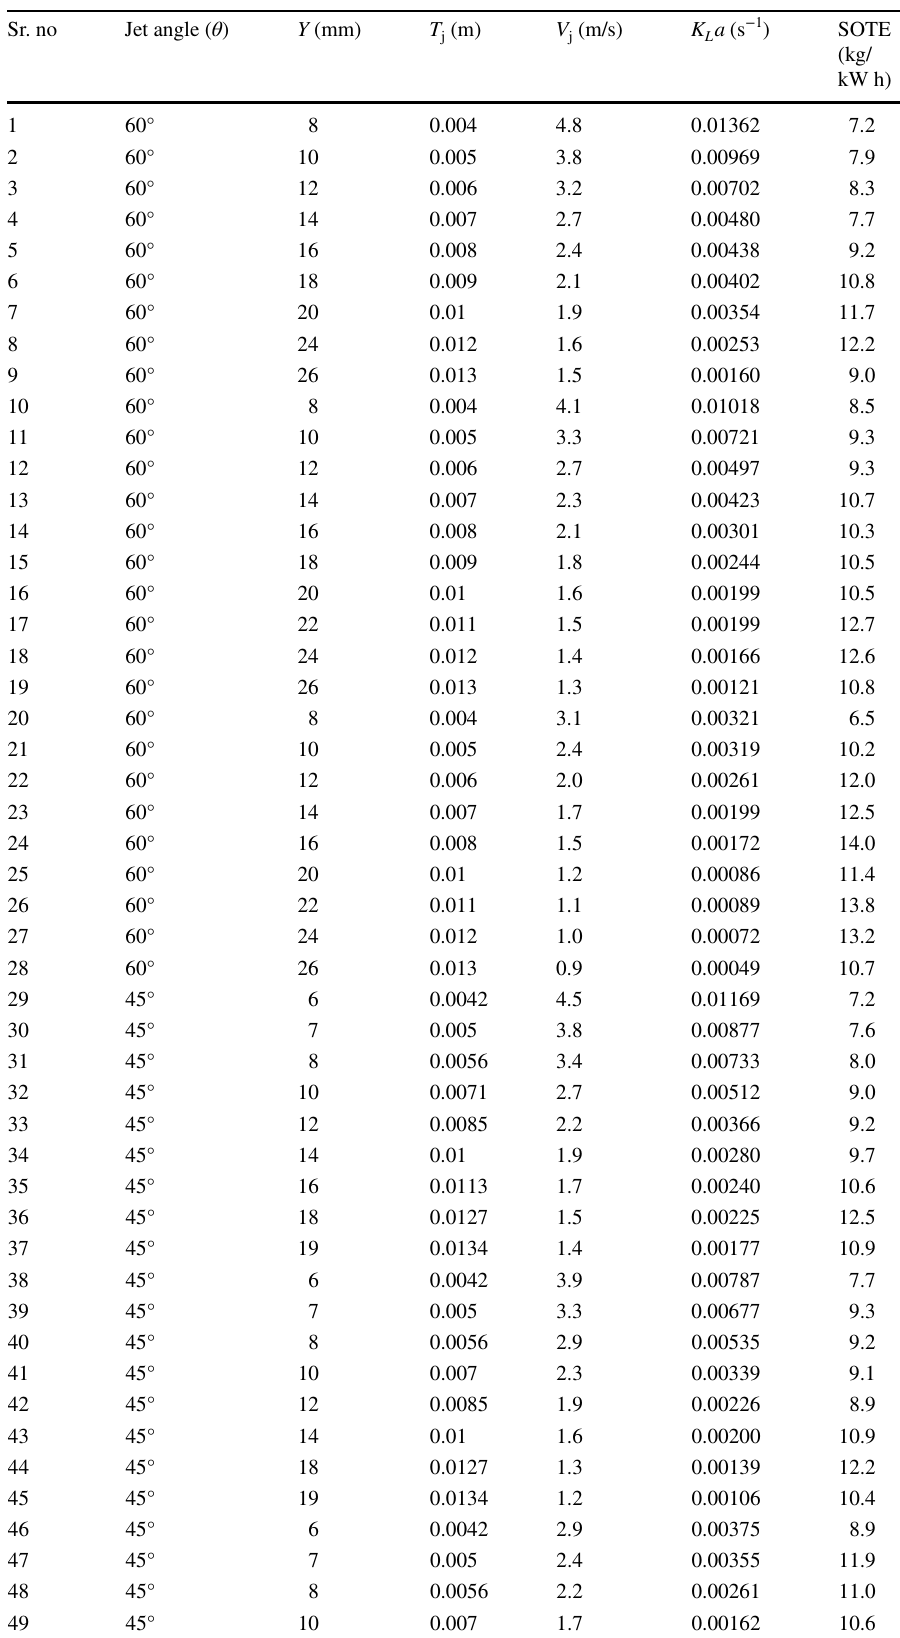
Table 1 Results of K L a and SOTE for the jet